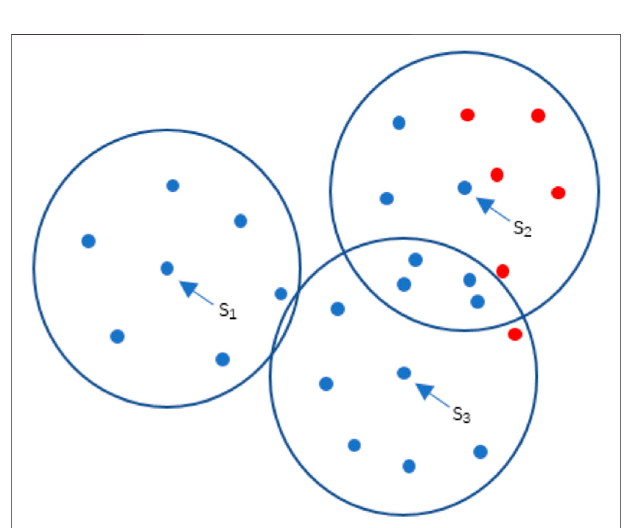
FIGURE 4 | Schematic of the rule of BEVD